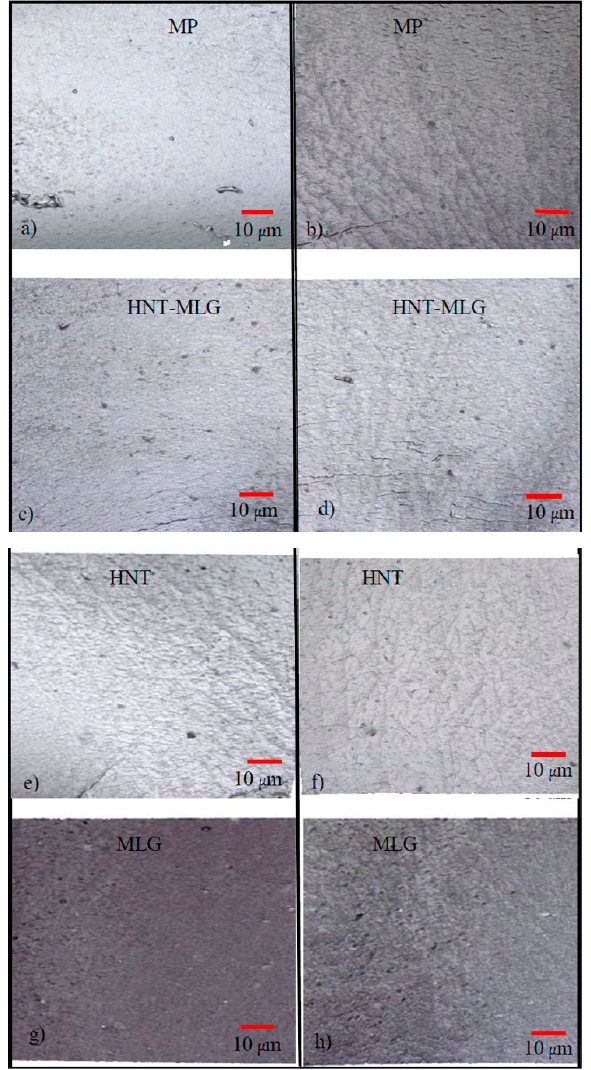
Figure 10. Surface profile of nanocomposites before and after water exposure: ( a ) monolithic polyester before water exposure; ( b ) monolithic polyester after water exposure; ( c ) HNT-MLG nanocomposites before water exposure; ( d ) HNT-MLG nanocomposites after water exposure; ( e ) HNT nanocomposites before water exposure; ( f ) HNT nanocomposites after water exposure; ( g ) MLG nanocomposites before water exposure; ( h ) MLG nanocomposites after water exposure.